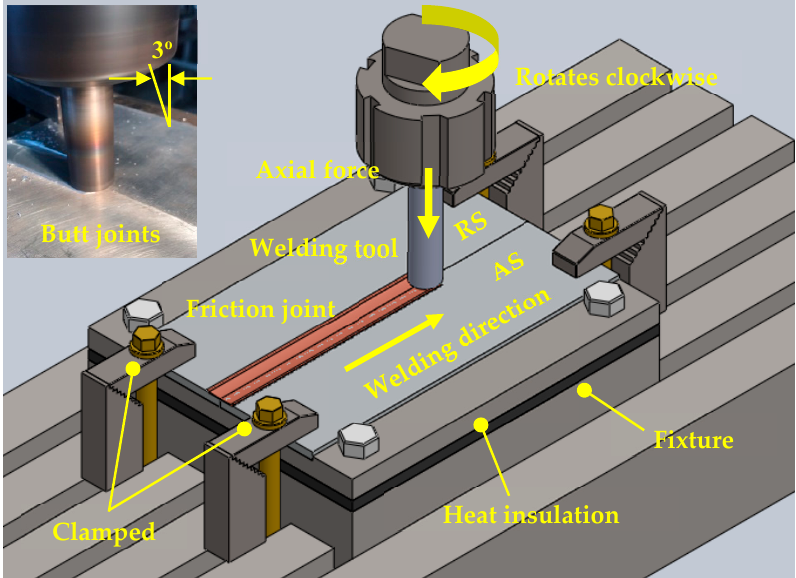
Figure 3. The schematic view of the steps for principle FSWp of SSM 6063 aluminum alloys.